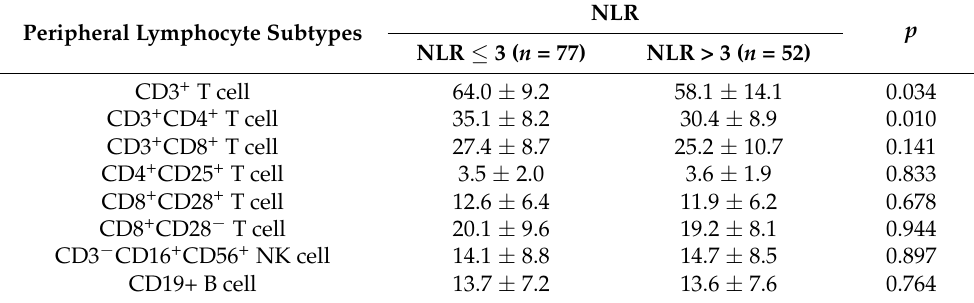
Table 5. Peripheral lymphocyte subsets percentage in MBC patients with low and high baseline